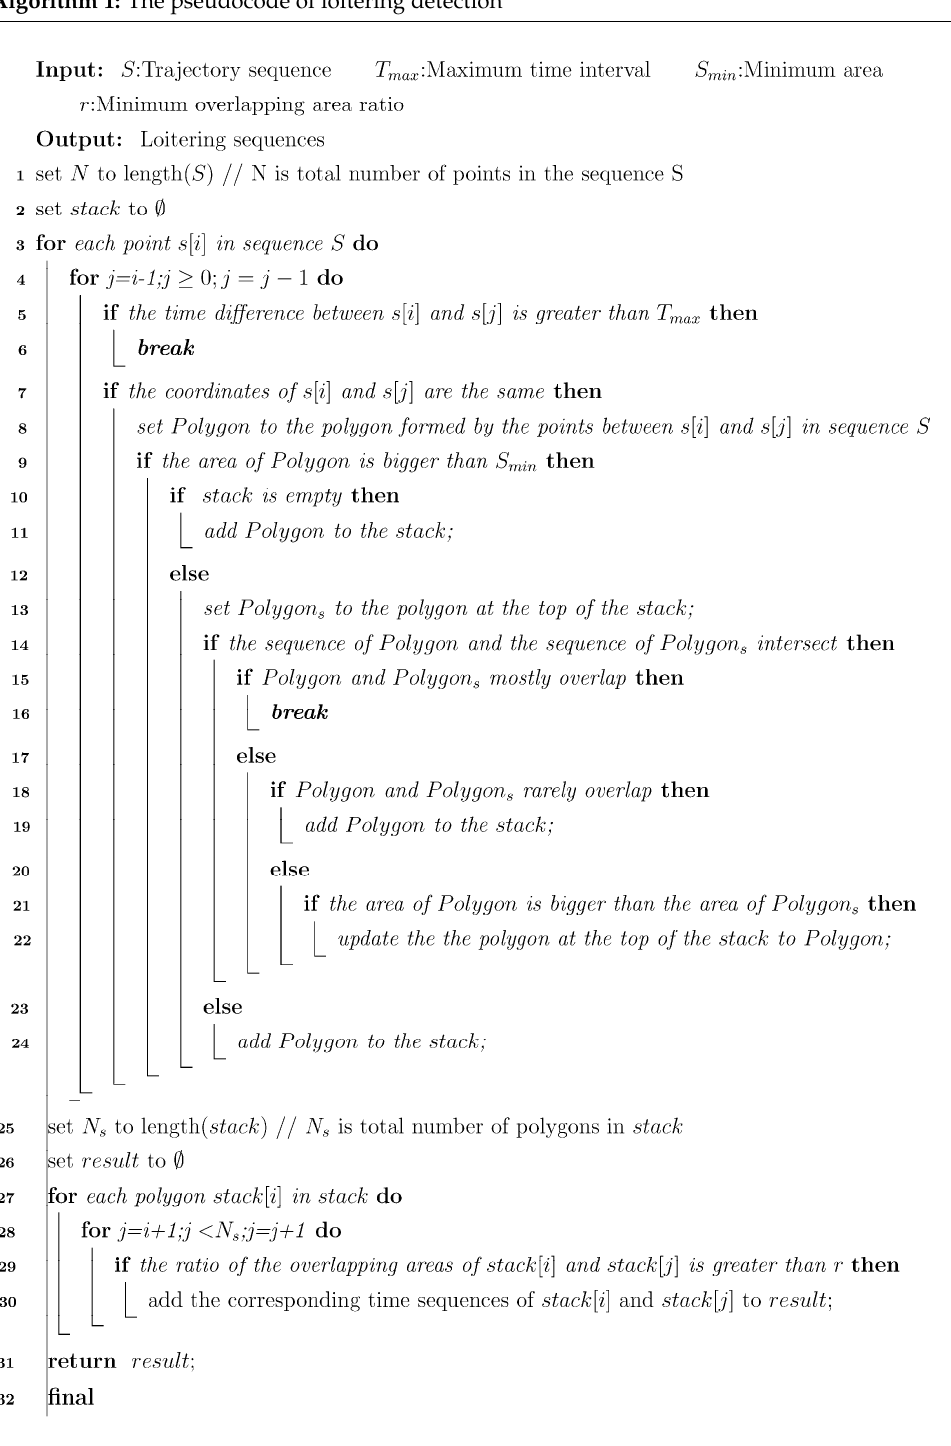
Algorithm 1: The pseudocode of loitering detection